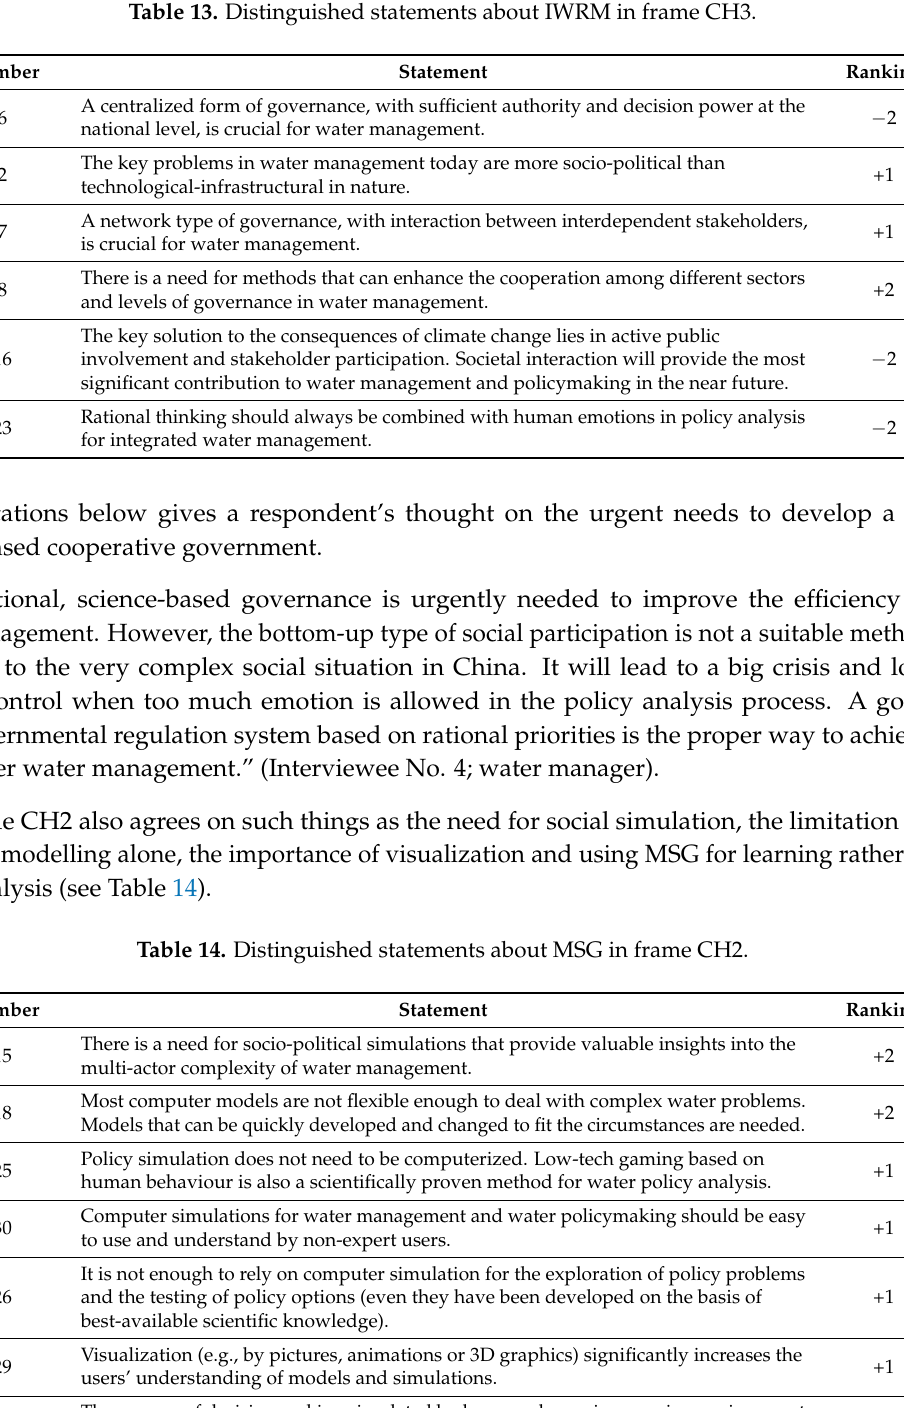
Table 13. Distinguished statements about IWRM in frame CH3.